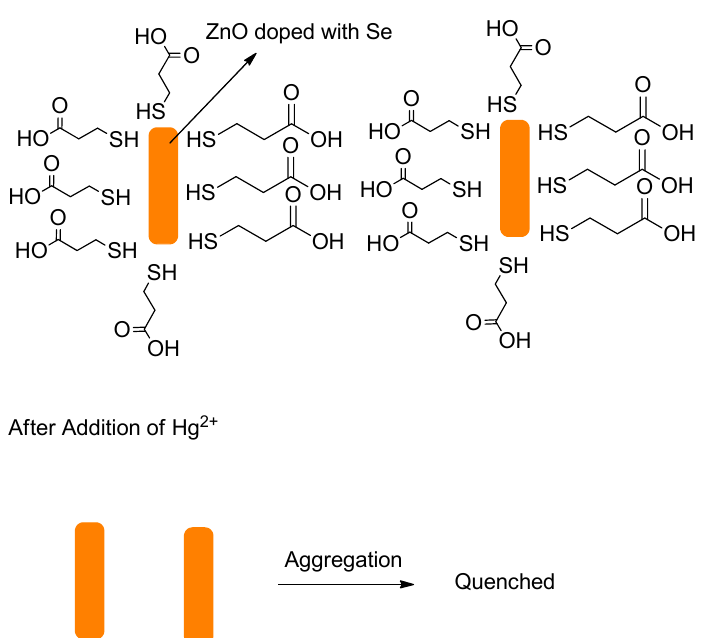
Figure 67. Hg 2+ –based detection from ZnO nanorod doped with selenium and coated with 3–mercaptopropionic acid (3–MPA) by Rao et al.